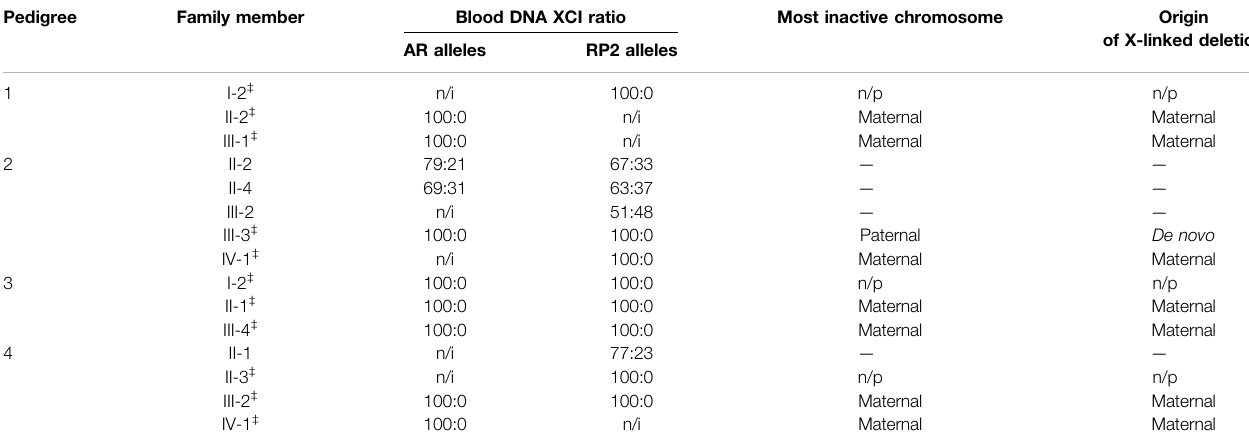
TABLE 2 | The XCI patterns of the female relatives in four pedigrees.